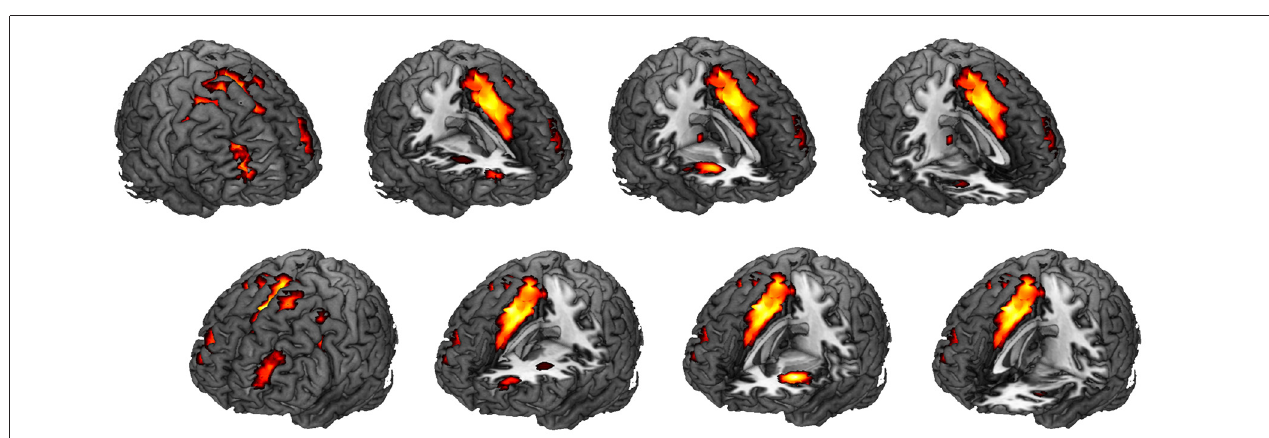
FIGURE 4 | Spatial map for the component that was most correlated with the task. One sample t -test was performed for this spatial map (corrected for multiple comparisons with the FDR, p < 0.01). See Table 1 for specific regions, T values and montreal neurological institute (MNI) coordinates. This component showed the highest positive spatial correlation (0.57) with an SN template. FDR, false discovery rate; SN, salience network.